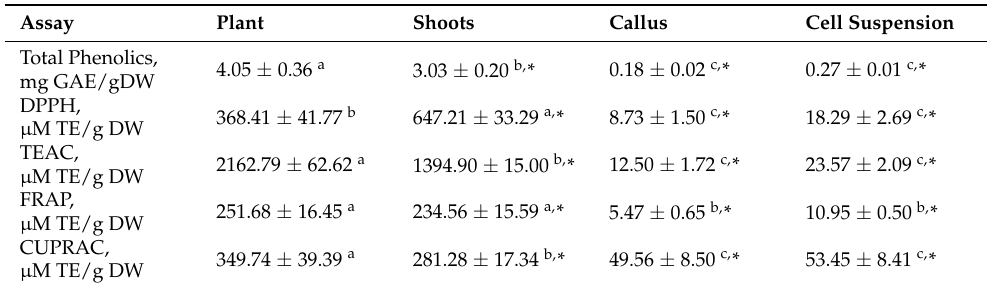
Table 2. Antioxidant activities of methanol extracts of G. jasminoides plant leaves, in vitro shoot, callus, and cell suspension cultures. Assay Plant Shoots Callus Cell Suspension Total Phenolics, mg